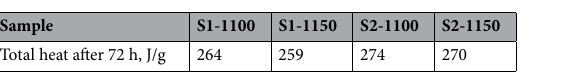
Table 2. Cumulative heat of eco-friendly cement